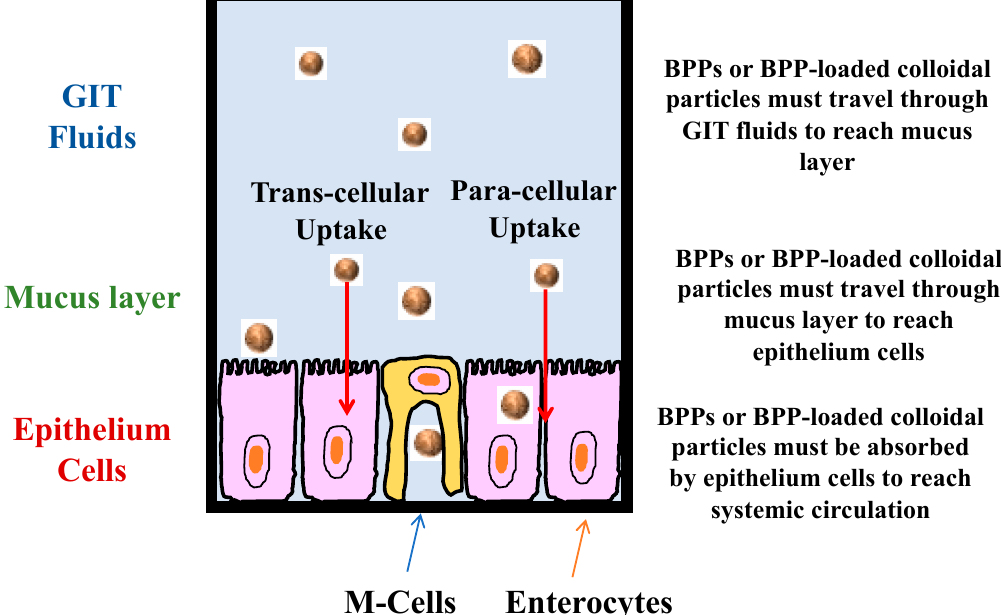
Figure 3. BBPs or BBP-loaded colloidal particles must move through the GIT fluids and mucus layer and then be absorbed by the epithelium cells before they can reach the systemic circulation. It should be noted that the M-cells are actually in the Peyer’s patches and only make up a small percentage ( < 5%) of the total intestinal cells. In practice, BPP-loaded colloidal particles are rarely absorbed through M-cells in